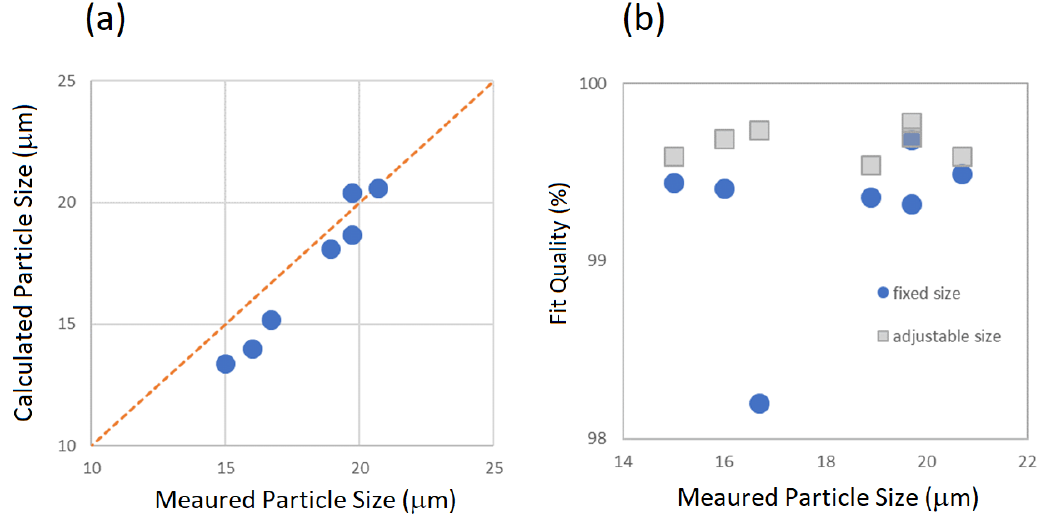
Figure 7. Comparison of the results of particle size determination through direct measurements by confocal microscopy and evaluation by fitting the compression test data: ( a ) showing a comparison between the calculated and the measured values, and ( b ) the fitting quality for the two procedures (Figures 5 and 6).